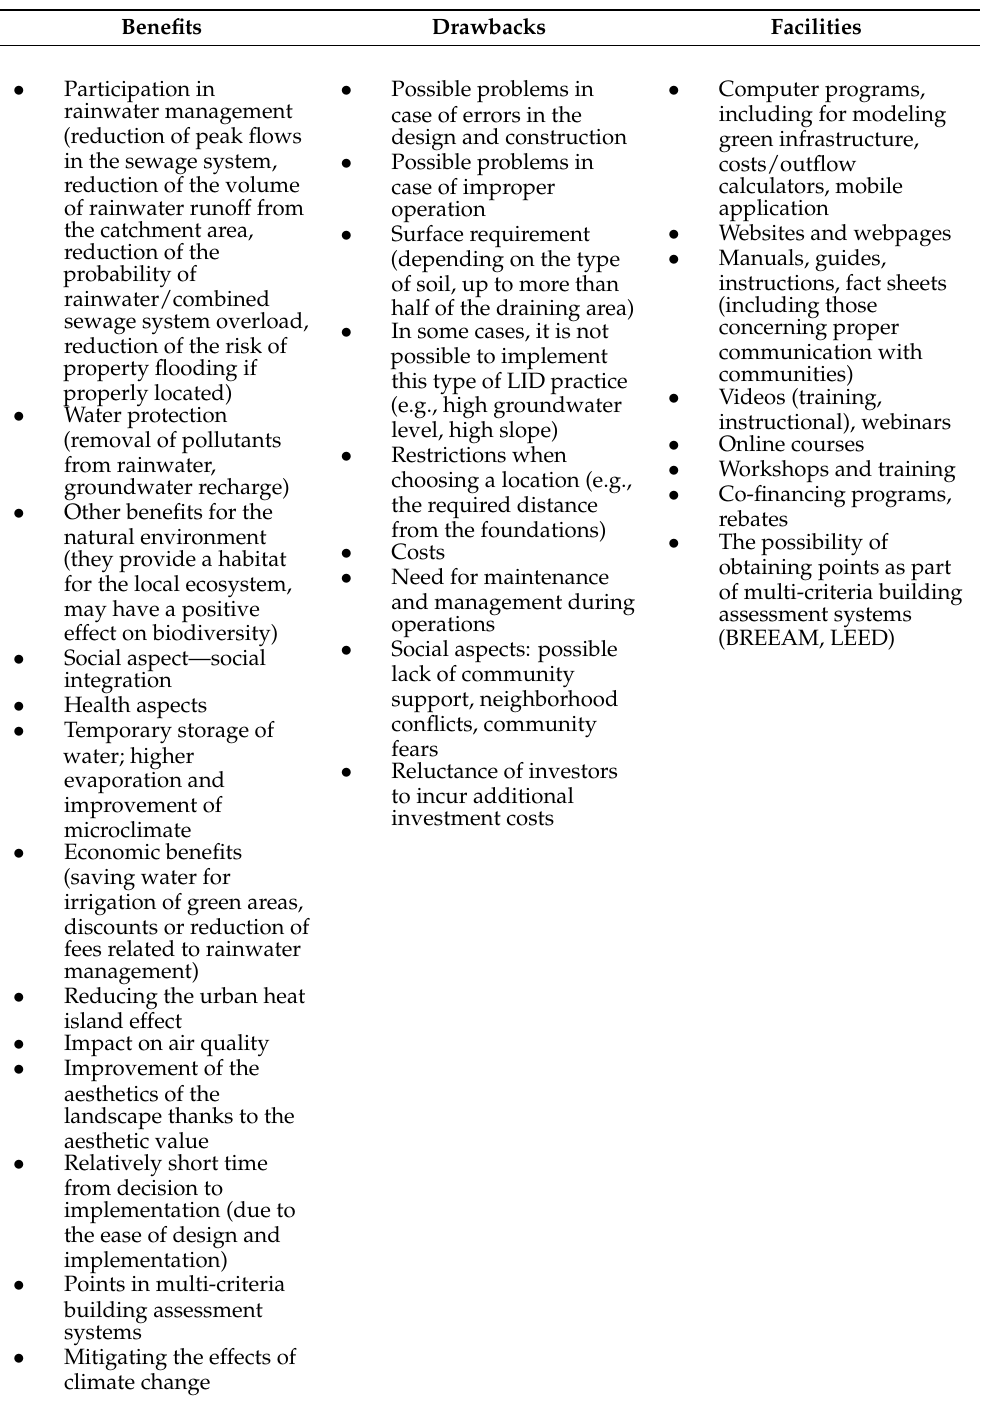
Table 1. List of benefits, inconveniences, and facilitations in the implementation of rain gardens in the city, own study based on the literature